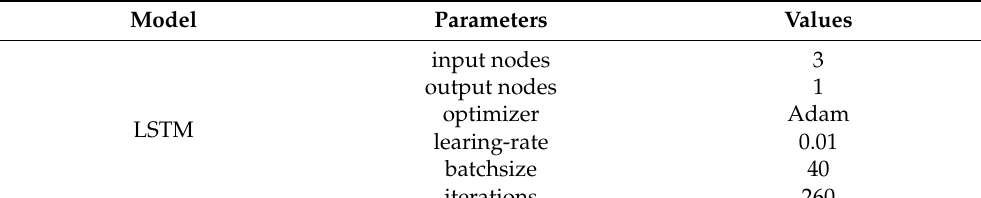
Table 4. Parameters and structure of LSTM.